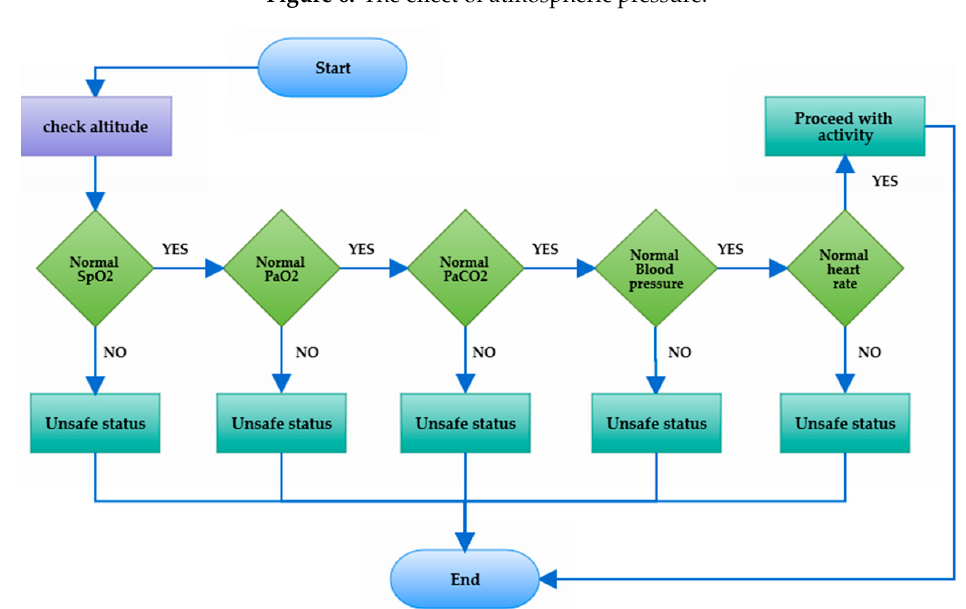
Figure 7. A simple flowchart of altitude and biomarker rules.